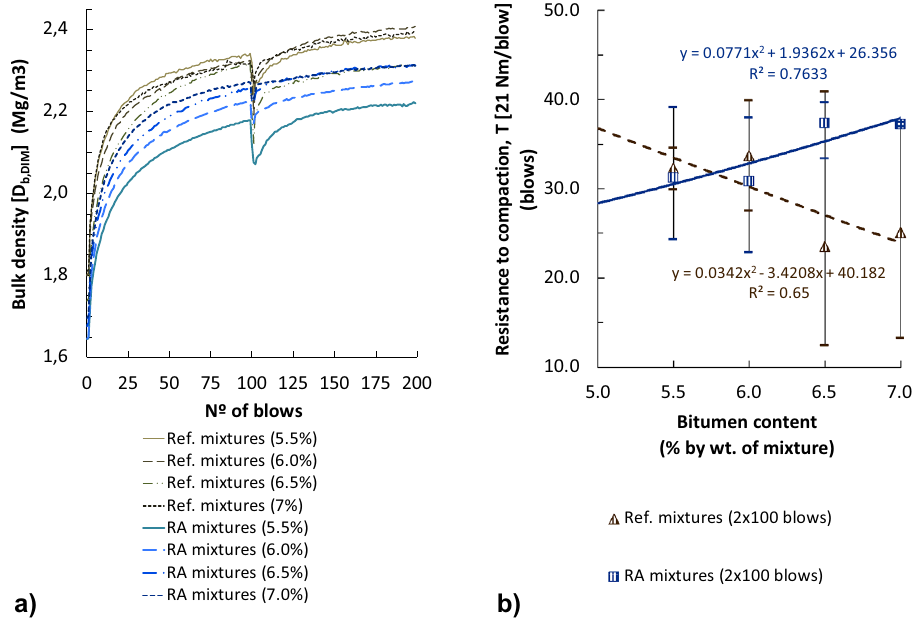
Figure 5. Compactability test results on cylindrical specimens (EN 12697-10): ( a ) bulk density (Proced. D: geometric) for different bitumen contents; ( b ) resistance to compaction of specimens compacted with 2 × 100